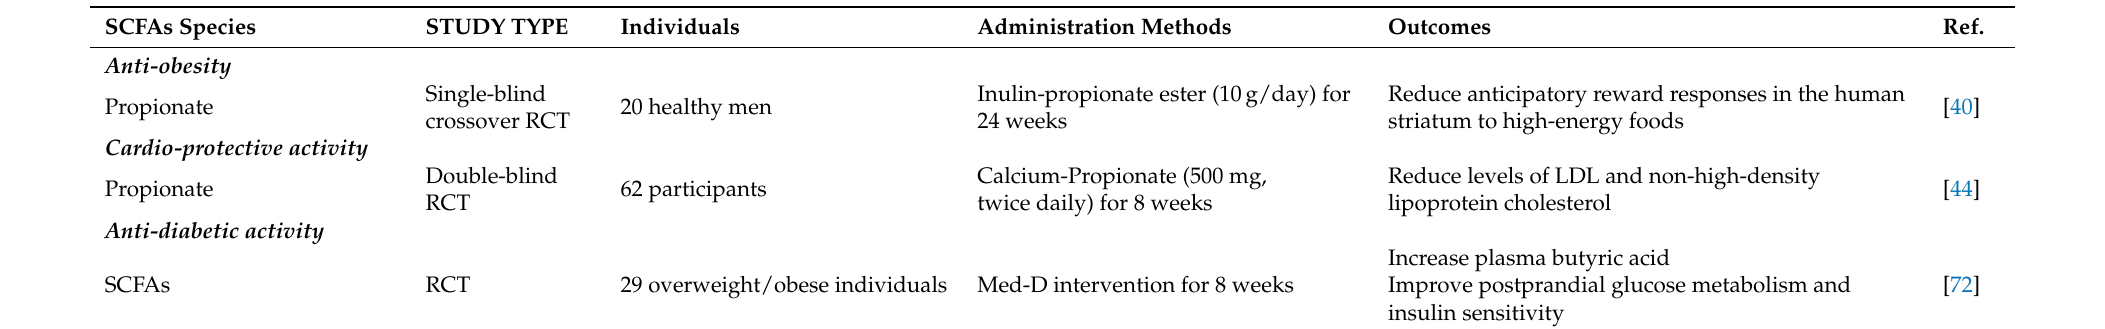
Table 3. Health benefits of SCFAs from clinical